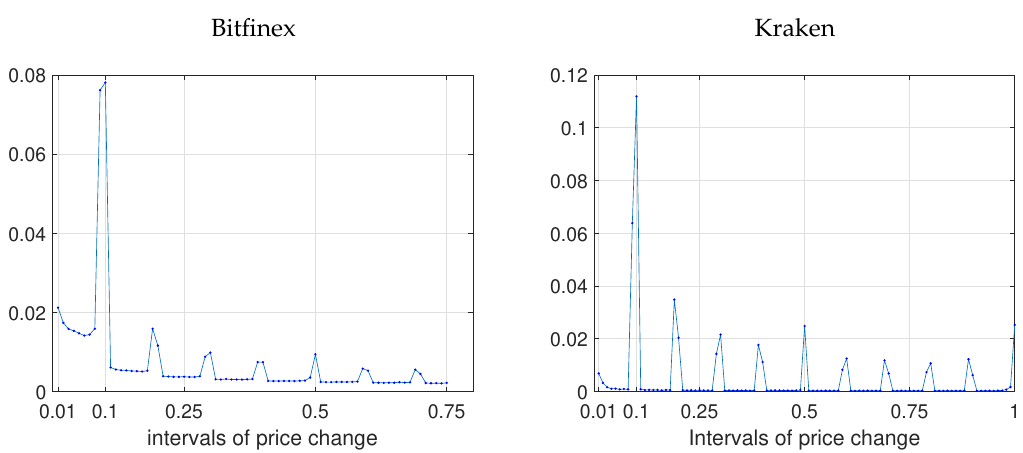
Figure 2. Price change histograms. Note. The figure presents histograms of price change sizes which illustrate the relative frequency that a price change of a given size occurs in the sample of Bitfinex (left plot) and Kraken (right plot). The step size of a price change is 0.01